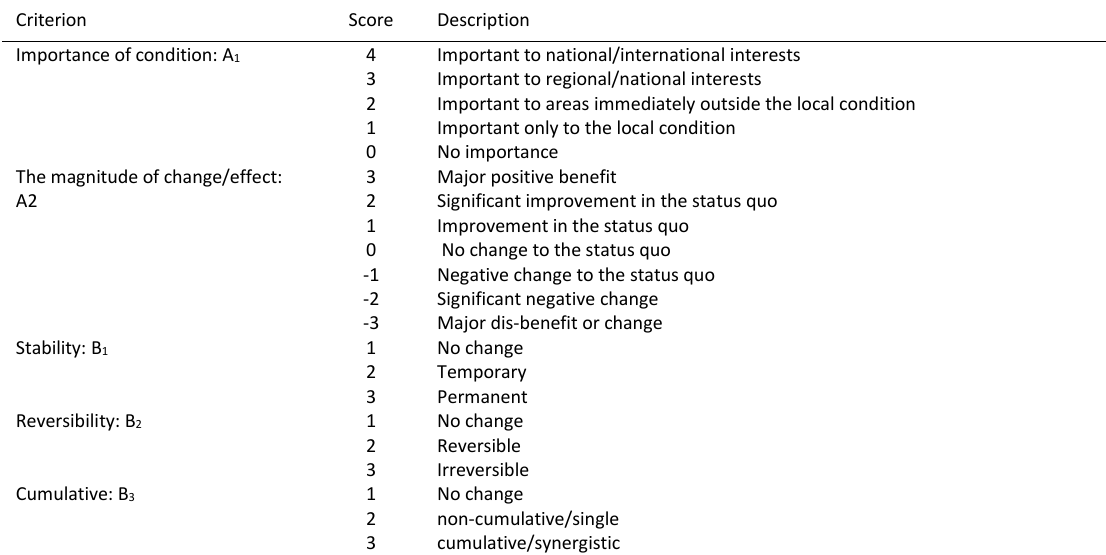
Table 6: Criteria and their scoring in the RIAM method